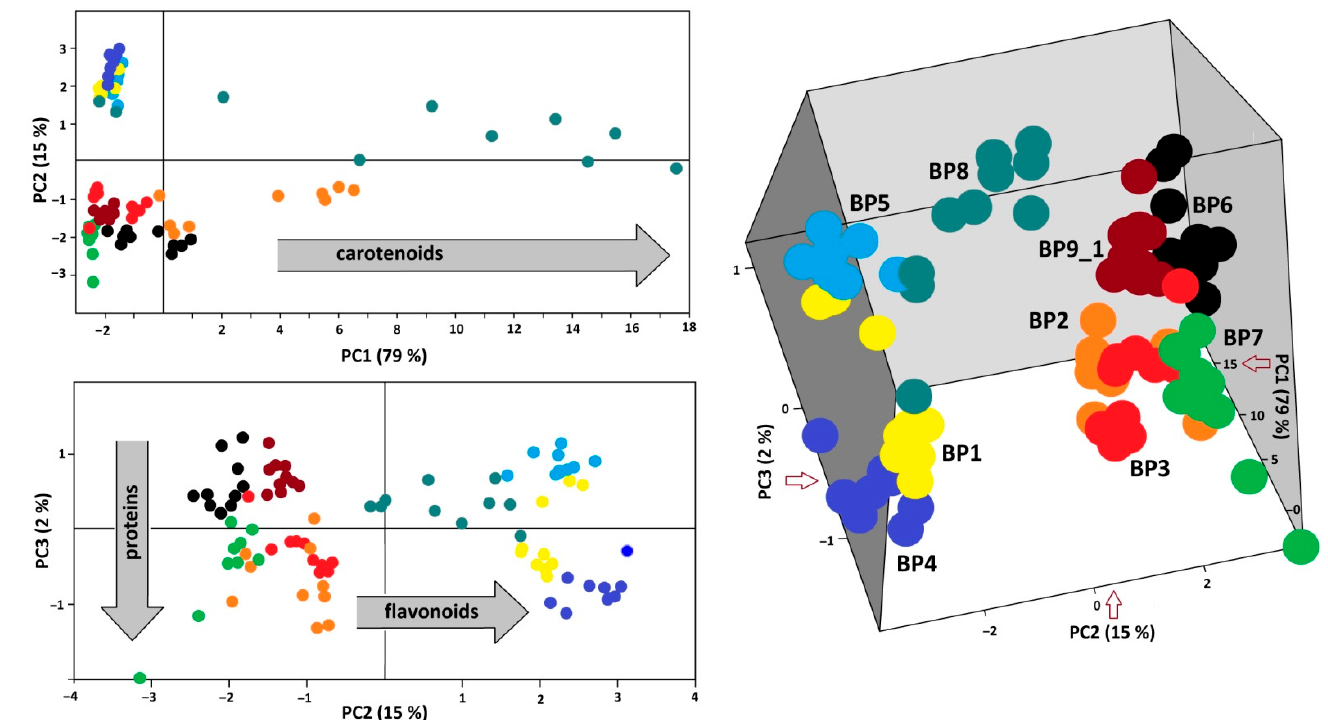
Figure 4. The 2D (left) and 3D (right) score graphs for PCA of FT-Raman data (300–1900 cm − 1 ) of BP1–8 and BP9 _1.